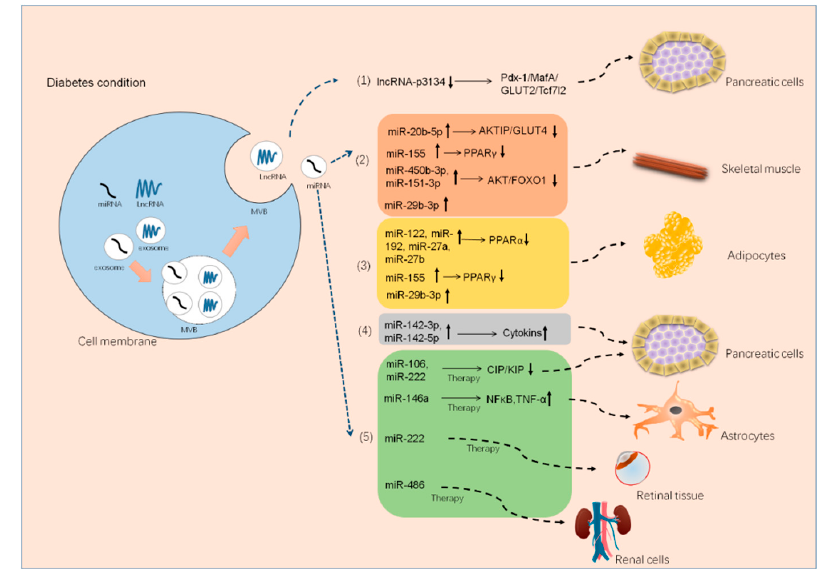
Figure 3. The molecular mechanisms by which exosomes containing miRNA and long noncoding RNA (lncRNA) regulate communication between organs. In the diabetic state, miRNA- and